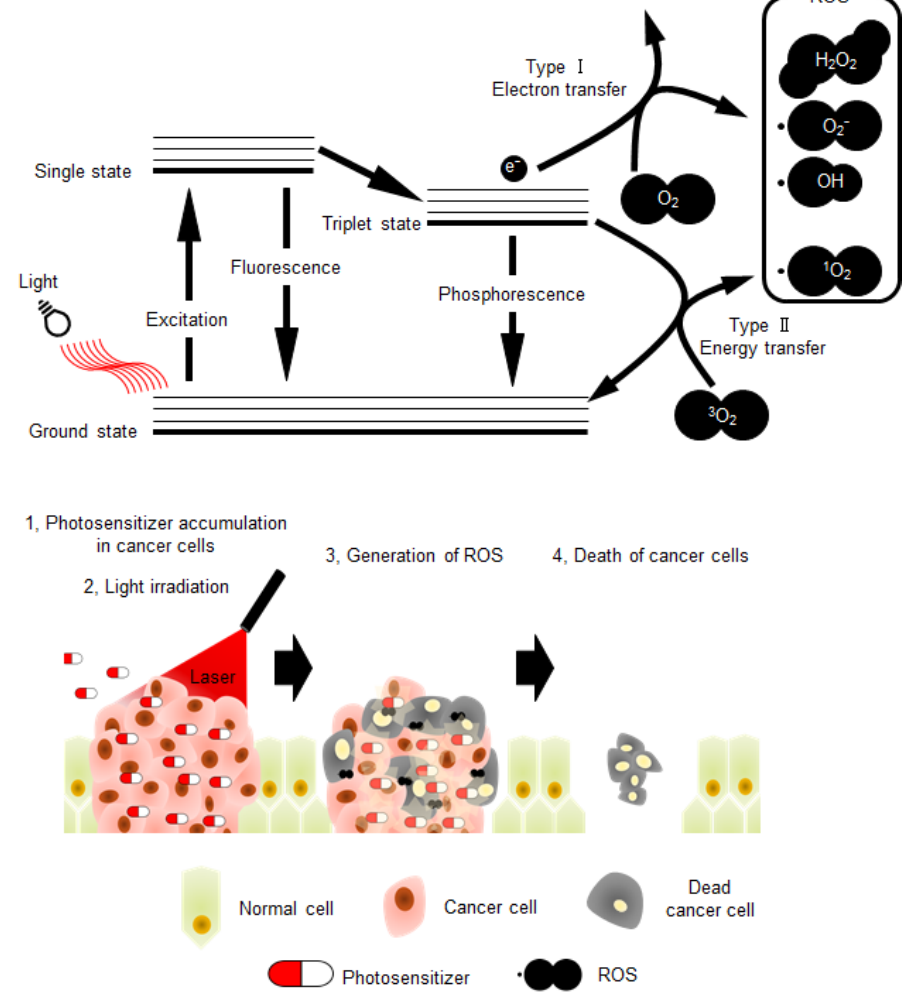
Figure 1. The schematic illustration of photochemical reactions in photodynamic therapy (PDT), and schematic model depicting the PDT strategy. ROS: reactive oxidative species.